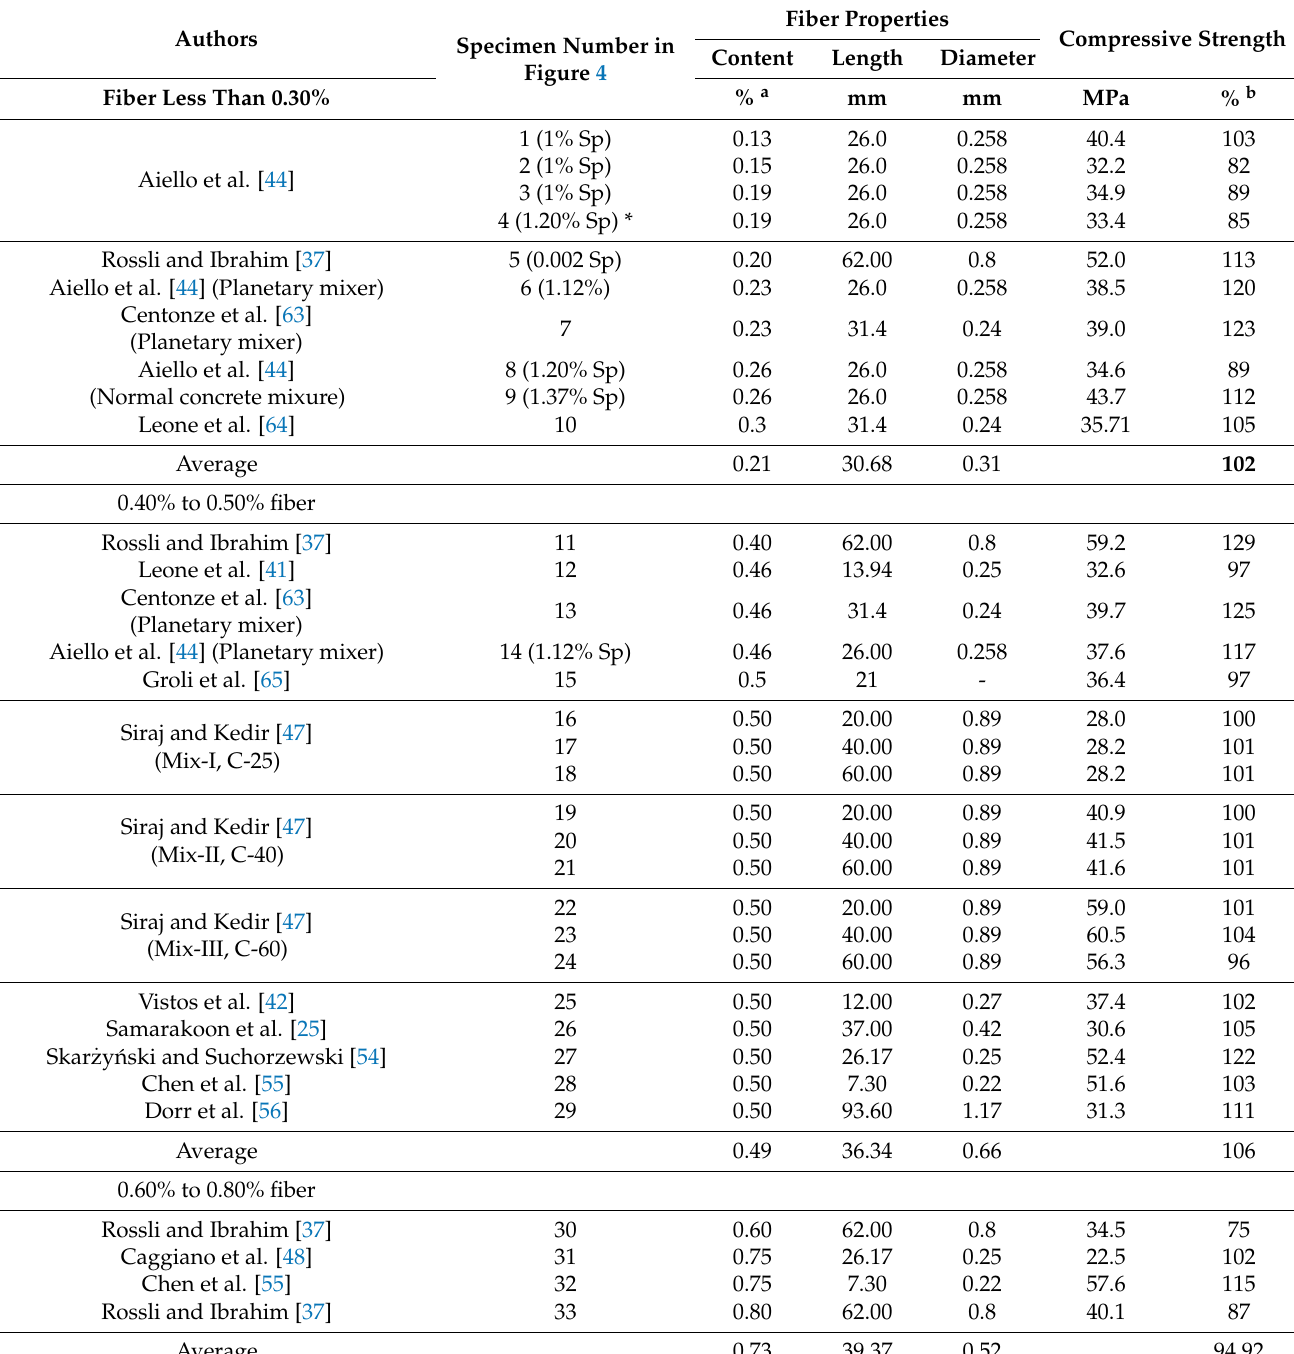
Table 2. Results of compressive strength’s percent comparison and fiber properties of the concrete encompassing less than 1% of RSF by its volume